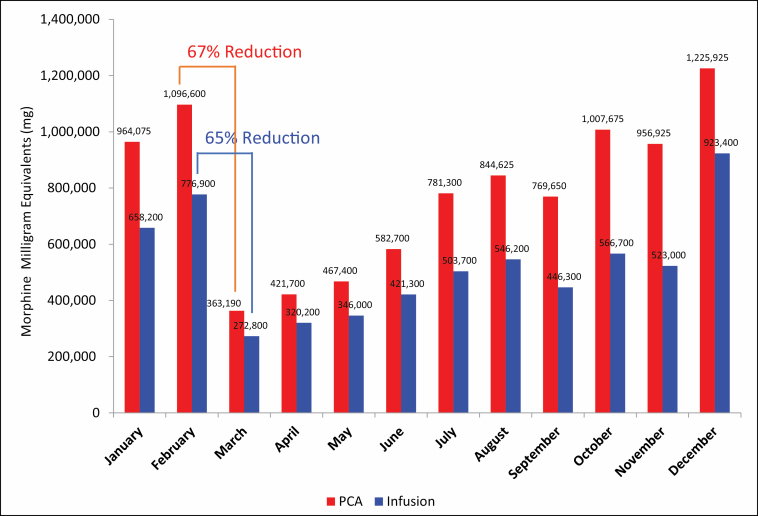
Opioid patient-controlled analgesia (PCA) and opioid infusions dispensed for inpatient and operating room care in 2018